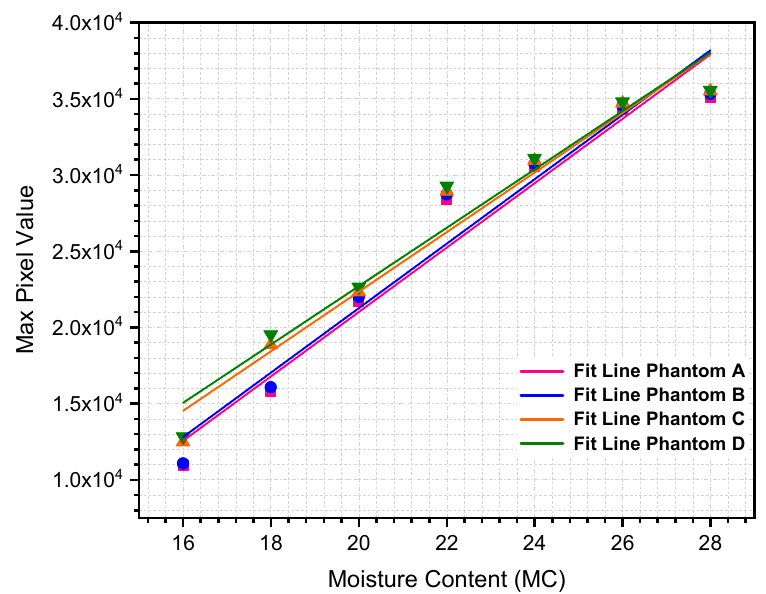
Figure 5. Percentage of maximum pixel value using NOSER algorithm. Table 5. Percentage of maximum pixel value using Tikhonov Regularization algorithm.